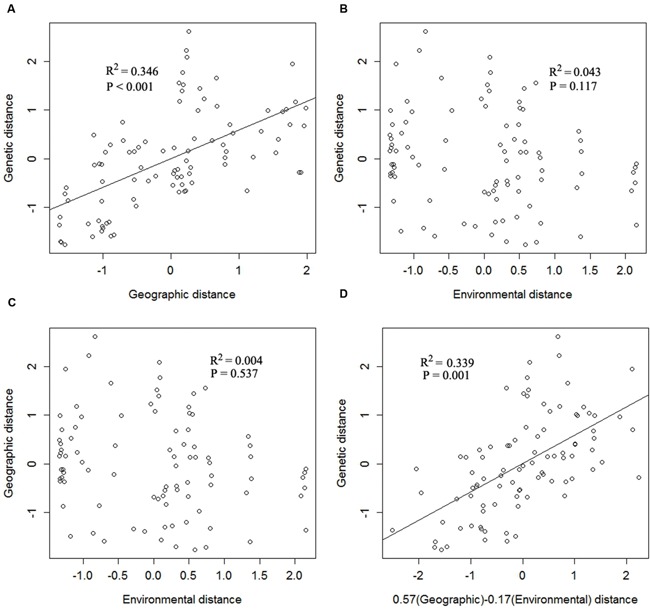
Multiple matrix regression with randomization analysis (MMRR) scatter plots showing the relationships of (A) geographical and genetic distance, (B) environmental and genetic distance, (C) environmental and geographical distance, and (D) the inferred multiple regression for the effects of geographical (βD = 0.57) and environmental distances (βE = -0.17) on genetic distance.